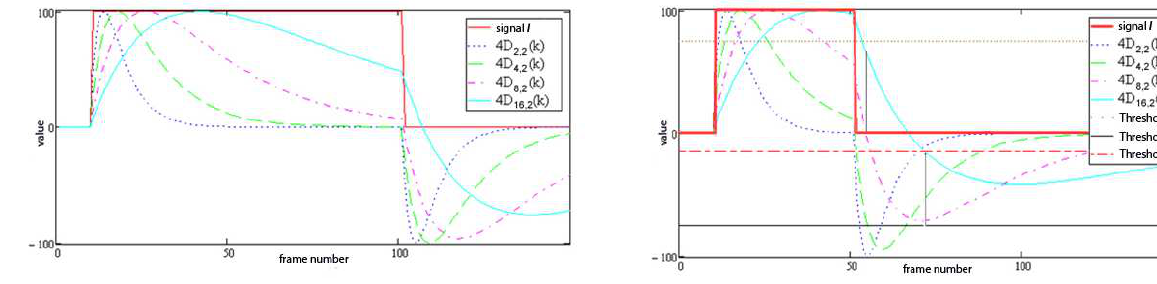
Figure 3: Dynamic brightness threshold correction based on